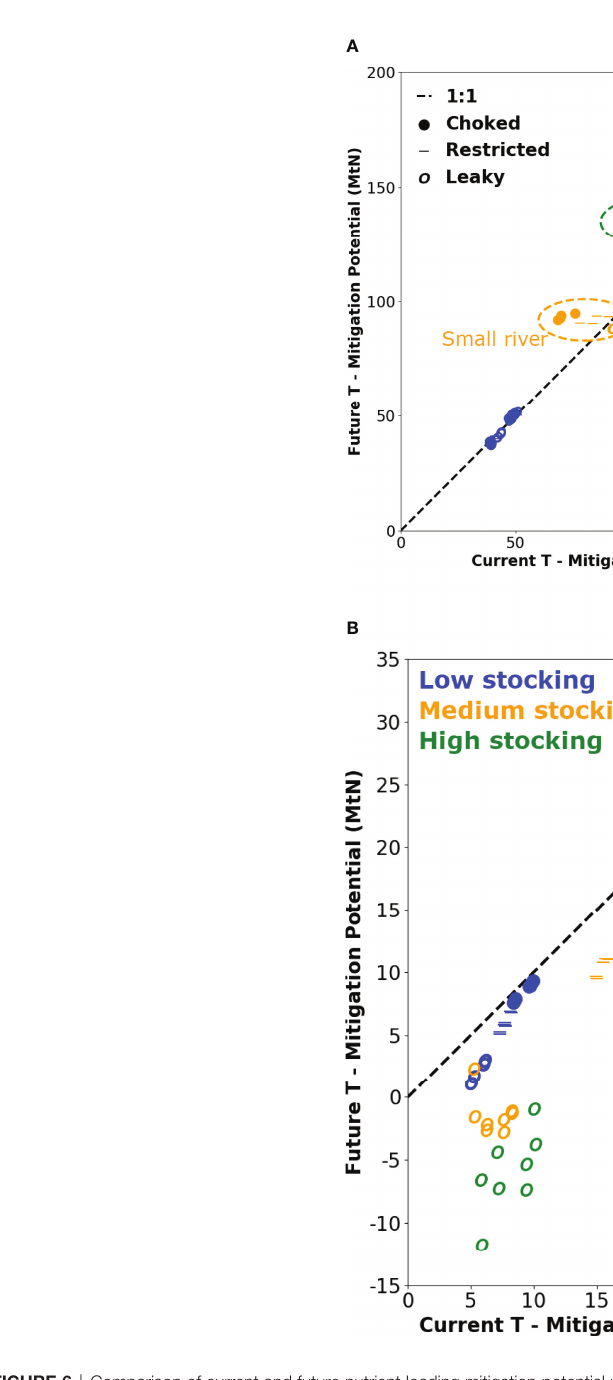
FIGURE 6 | Comparison of current and future nutrient loading mitigation potential provided by (A) mussel and (B) oyster aquaculture in the various scenarios of stocking area, nutrient loading (river size) and bay